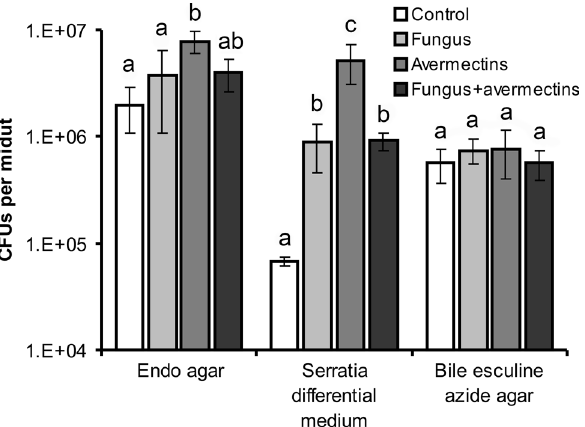
Figure 4. CFU count in the midgut of Colorado potato beetle larvae at 48 h after topical treatment with M. robertsii conidia, oral administration of avermectins and the combined treatment. Selective media for Enterobacteriaceae (Endo agar), Serratia (Serratia differential medium), Enterococcus and Lactococcus (bile esculin azide agar) were used. Different letters indicate significant differences between treatments (Dunn’s test, P <